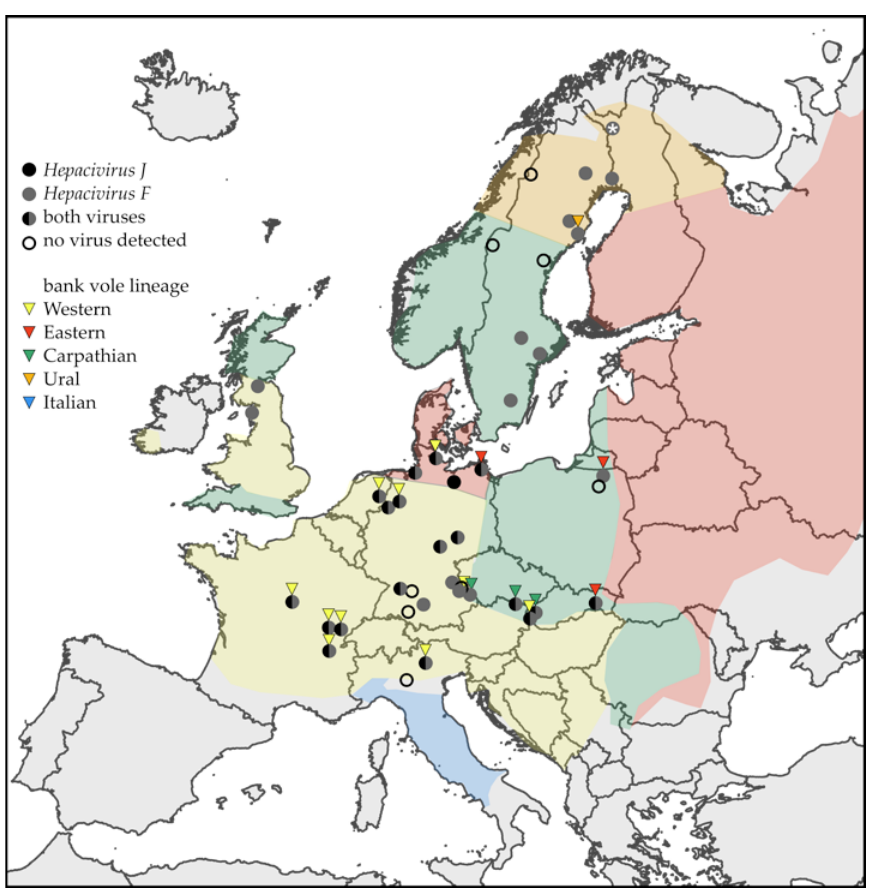
Figure 1. Map of bank vole and northern red-backed vole (*) trapping sites and the detection of Hepacivirus J (black) and Hepacivirus F (grey) in this study. Empty circles represent the lack of RNA detection of both hepacivirus species. Only trapping sites where five or more animals were sampled are shown. Colored areas correspond to the approximate distribution of the evolutionary lineages of the bank vole according to Filipi et al. [34], and colored triangles indicate evidence of the corresponding lineage in a bank vole in this study.